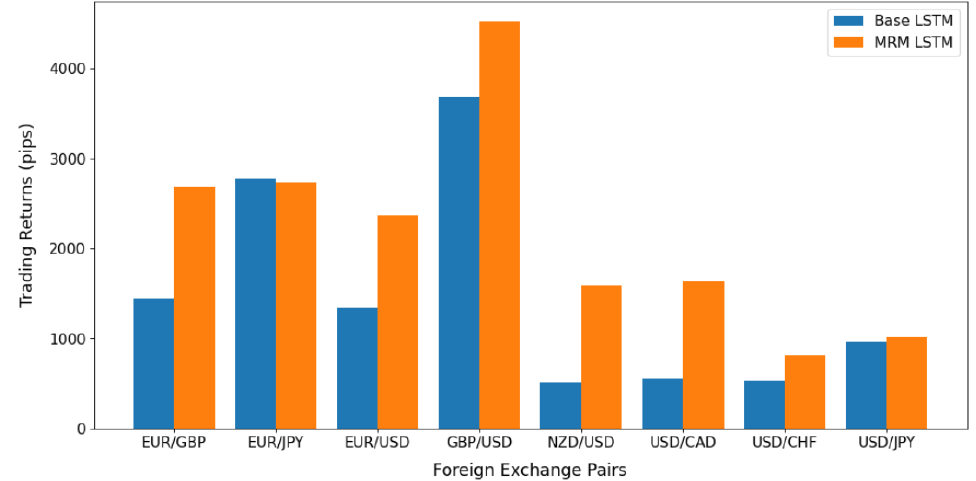
Figure 6. Comparison of Trading Returns for each of the Foreign Exchange Pairs.